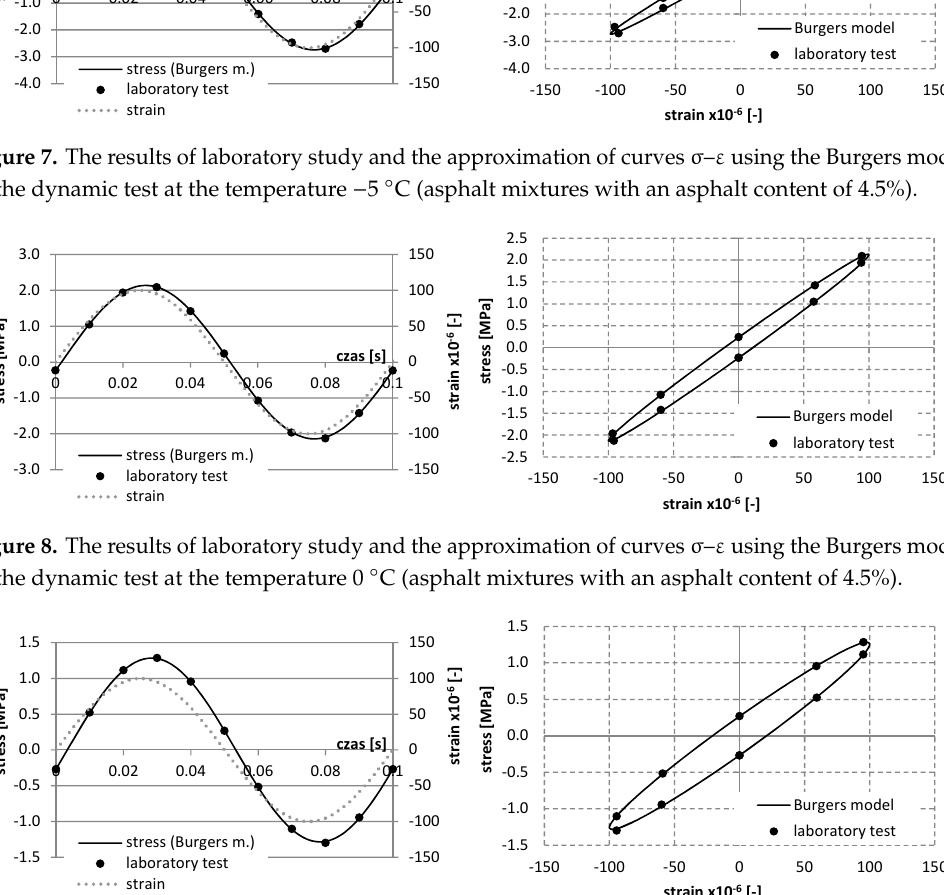
Figure 10. The results of laboratory study and the approximation of curves σ – ε using the Burgers model in the dynamic test at the temperature 25 °C (asphalt mixtures with an asphalt content of 4.5%). It may be noticed that the obtained parameters differ. Moduli of instant elasticity E 1 obtained in the dynamic 4BP test are about 5 to 13 times larger than those received in the static test. Similarly, moduli of delayed elasticity E 2 are about 5 to 7 times greater in the dynamic than in the static tests. On the other hand, viscosity coefficients η 1 and η 2 are about two and three times smaller in the dynamic test than in the static test, respectively. This results from the very short time of variable loading, and consequently, of the short time of the material deformation response. A comprehensive comparison of changes in parameter values for different temperatures and asphalt content is shown in Figure 11 (a static test) and Figure 12 (a dynamic test).